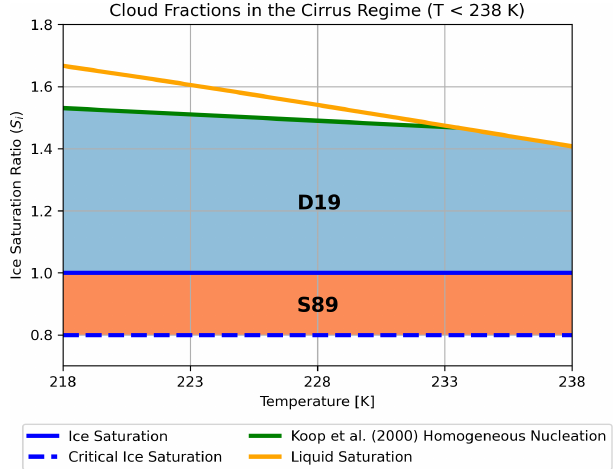
Figure 1. Cloud fraction schematic adapted from Dietlicher et al. (2019) showing the difference between the D19 and S89 approaches for calculating ice cloud fractions. The shaded areas show the tem- perature versus ice saturation ratio conditions where clouds can form, with the orange area for S89 and the blue area for D19. The blue line is the ice saturation line ( S i = 1.0), the blue dotted line is the critical ice saturation line for cloud formation in the S89 ap- proach, the orange line is for liquid saturation with respect to ice saturation, and the green line is the homogeneous nucleation limit according to Koop et al.